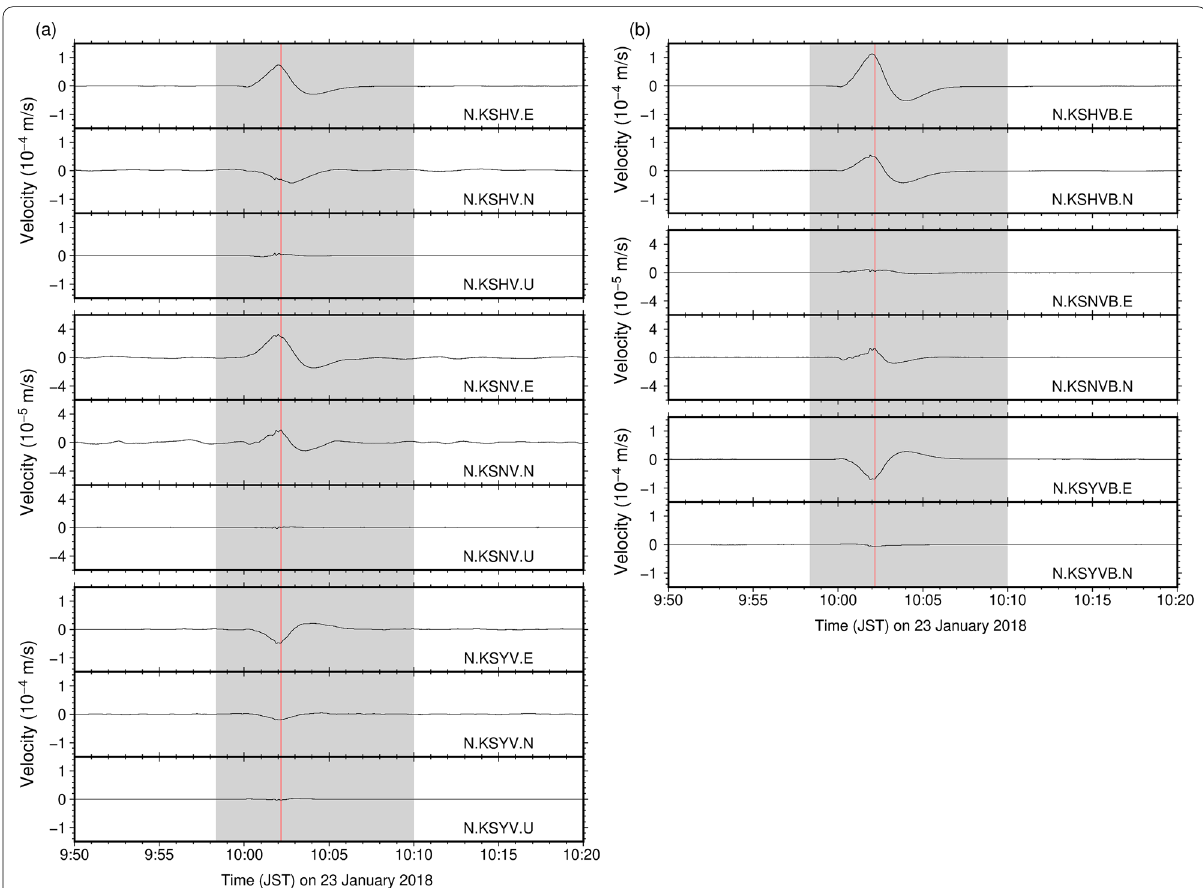
Fig. 4 Low-pass-filtered records. a Low-pass-filtered (10-s) velocity seismograms recorded by broadband seismometers, and b low-pass-filtered (10-s) tilt records converted into velocity waveforms. The red line and the gray band have the same meanings as those in Fig.